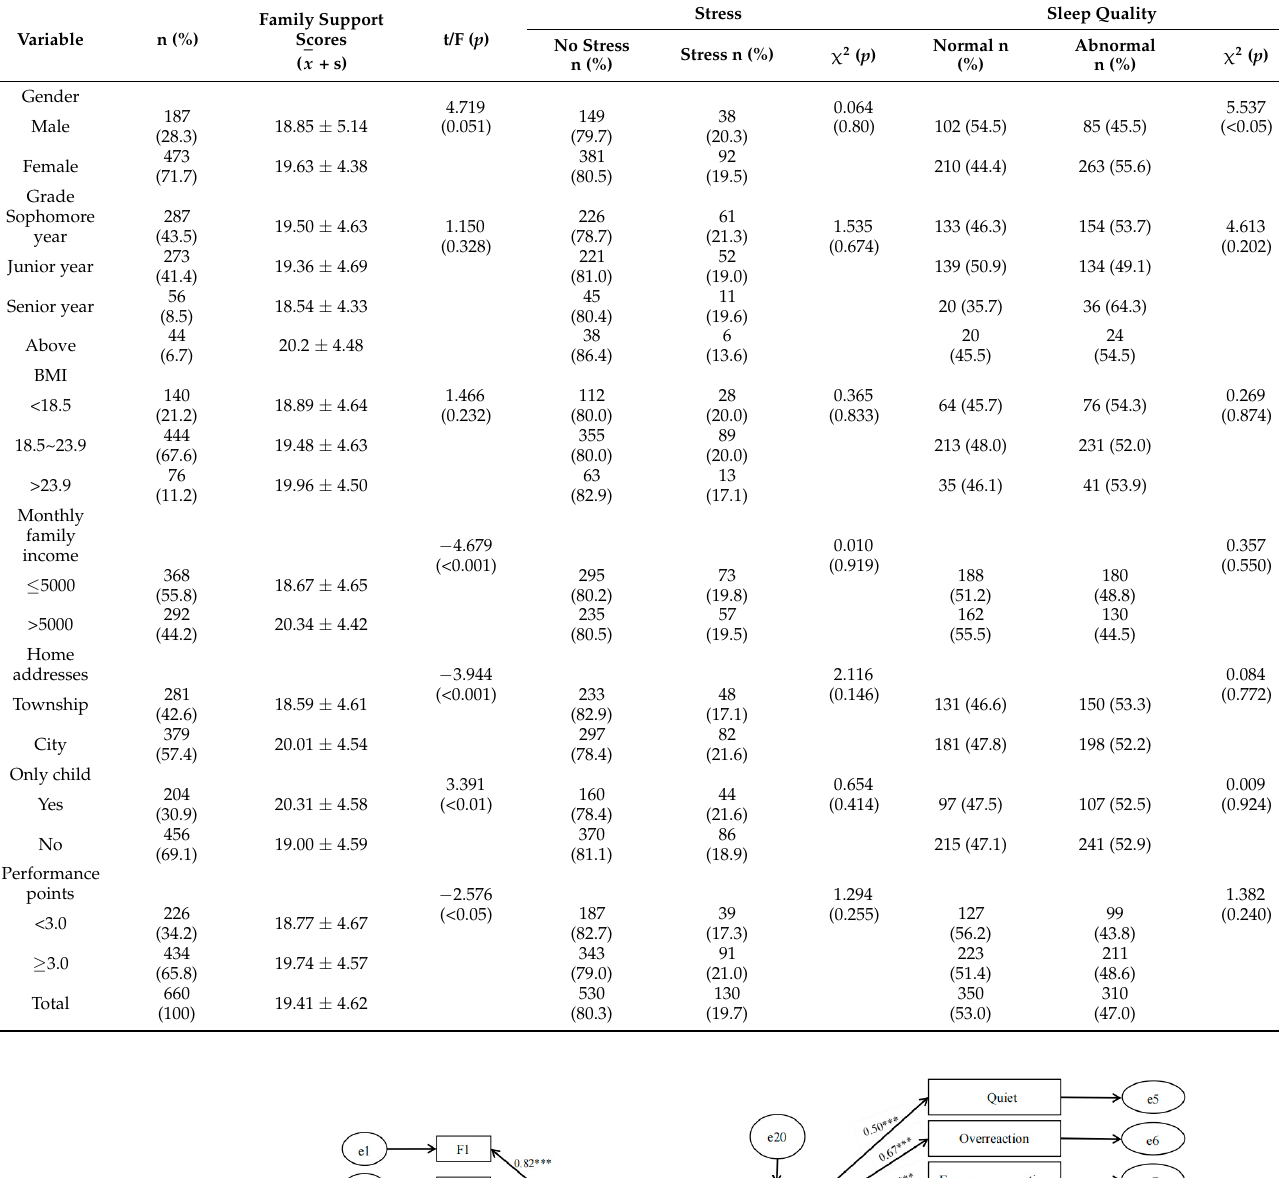
Table 1. Comparison of family support, stress, and sleep quality levels among different demographic and sociological characteristics (n = 660).